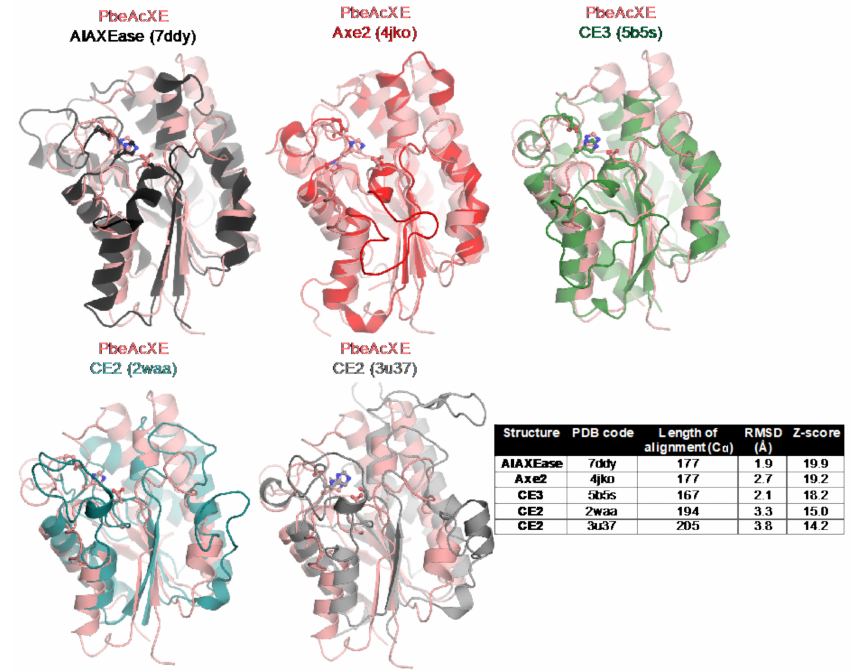
Figure 5. A crystal structures of acetyl xylan esterase from Prolixibacter bellariivorans ( Pbe AcXE) is superimposed with Al AXEase from Arcticibacterium luteifluviistationis (PDB ID 7ddy), Axe2 from Geobacillus stearothermophilus (PDB ID 4jko) [33], a CE3 enzyme from Talaromyces cellulolyticus (PDB ID 5b5s) [34], and CE2 enzymes from Cellvibrio japonicus (PDB ID 2waa) [35] and Butyrivibrio proteoclasticus B316 (PDB ID 3u37) [36]. The table shows the structurally most similar structures found through a Dali